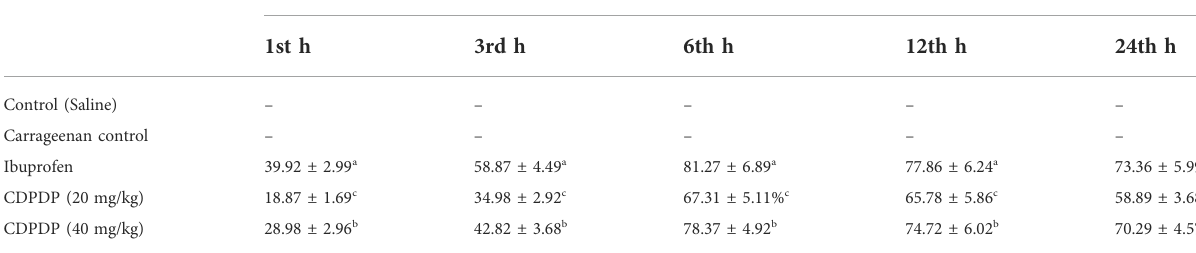
TABLE 2 Effect of CDPDP on carrageenan-induced paw edema in mice. Groups